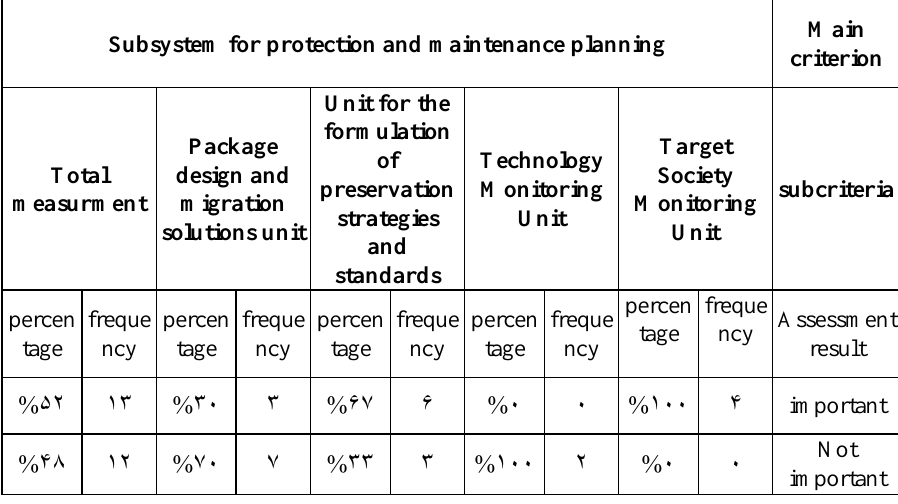
Table 5. Survey of the status of preservation and preservation